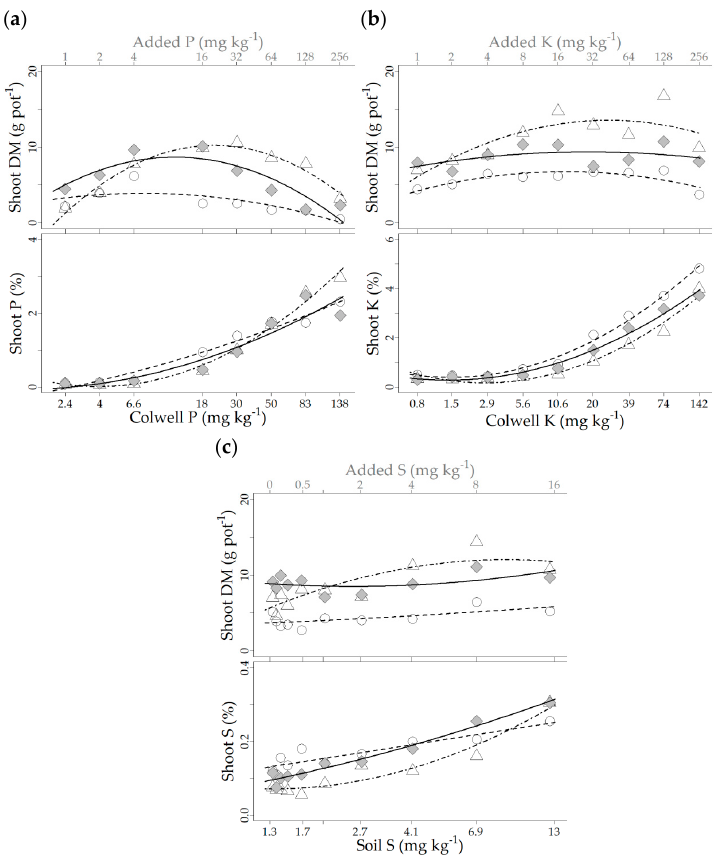
Figure 2. Shoot biomass response (g pot − 1 ) and shoot P, K or S concentration (%) in response to increasing levels of ( a ) Colwell P, ( b ) Colwell K or ( c ) Soil S. Circles, triangles, and diamonds represent Lanza ® , lucerne and Palma, respectively. Dashed, dotted and solid lines are fitted models for Lanza ® , lucerne and Palma, respectively. The scale on the X-axis is a log scale, and the grey text at the top of the panels is the level of nutrient added to treatments. Levels of Colwell P less than 4 and Colwell K less than 20 were below the detectable limits of the soil tests and have been estimated from smoothed models of soil test results vs. added